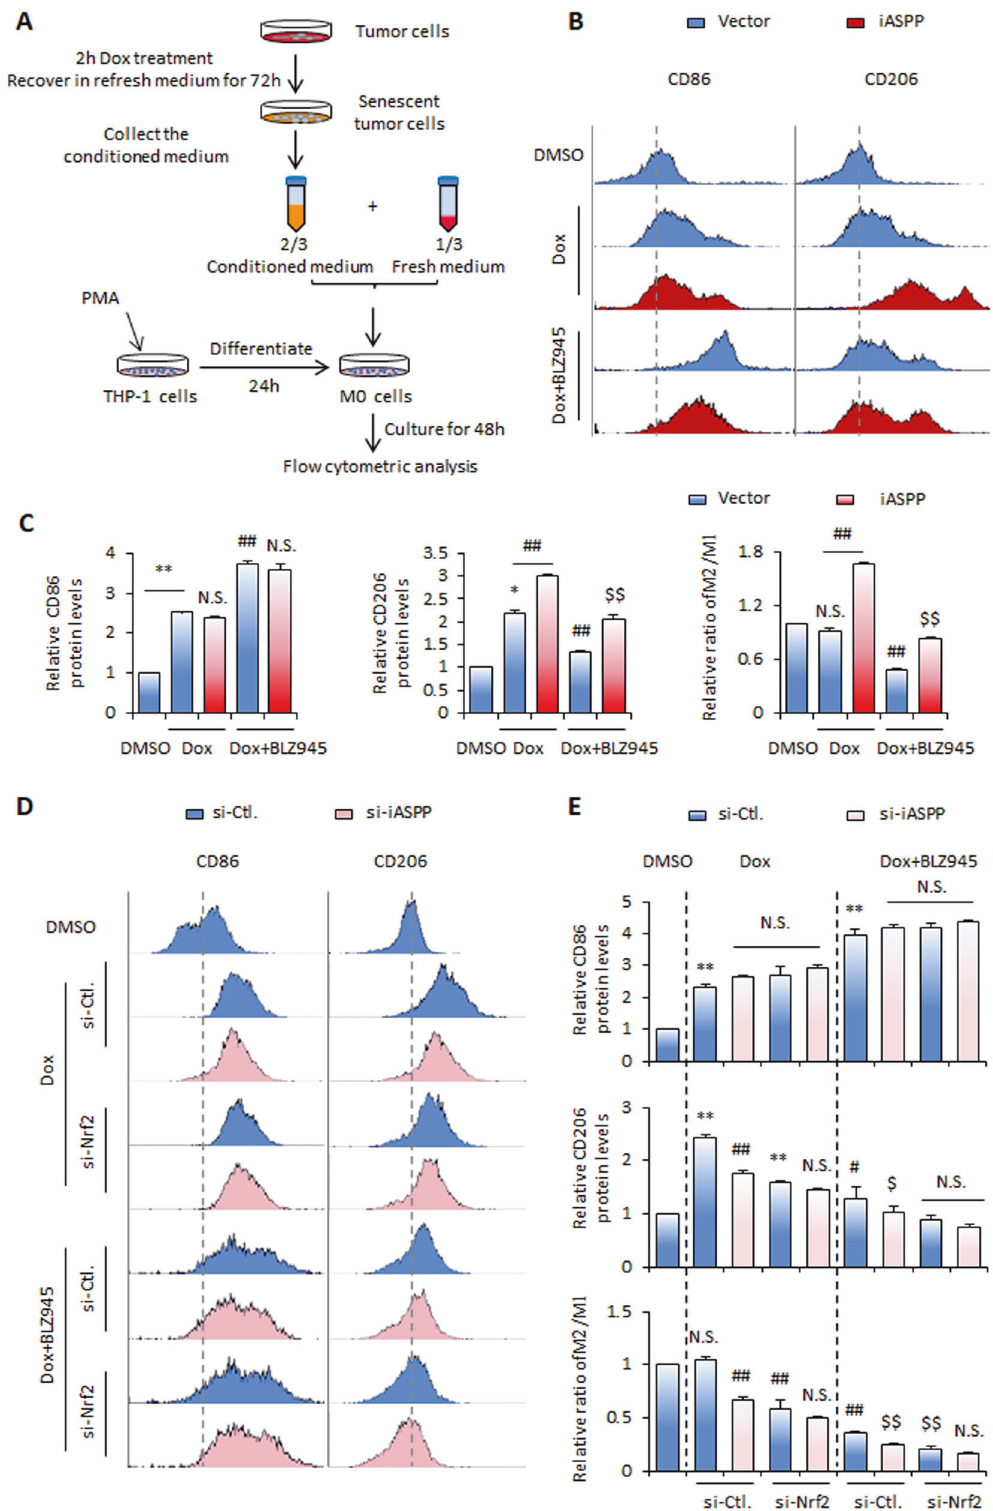
Fig. 4 iASPP-Nrf2-M-CSF regulates M2 polarization in vitro. A Schematic of the experimental strategies used to trigger macrophage polarization. B – E Expression levels of CD86 and CD206 were detected by fl ow cytometry in HCT116 cells after iASPP OE ( B , C ), and iASPP and/ or Nrf2 KD ( D , E ) with and without Dox and/or BLZ945 treatments. The quanti fi cation of the ratio of M2/M1 (CD206/CD86) is calculated and shown in bar graphs ( C , E ). Values are mean ± SD from three independent experiments; * P < 0.05, ** P < 0.01, compared with DMSO ( C , E); # P < 0.05, ## P < 0.01, compared with Dox -treated control ( C , E ); $ P < 0.05, $$ P < 0.01, compared with Dox and BLZ945-treated control ( C , E ); N.S., not signi fi cant ( C , E ).